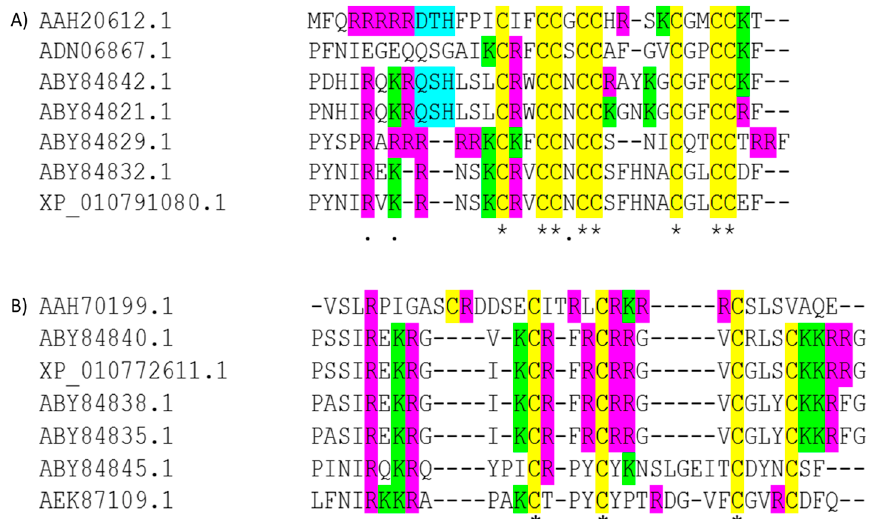
Figure 1. Multiple sequence alignment of Liver-Expressed Antimicrobial Peptides (LEAPs) from human (AAH20612.1, AAH70199.1); Dissostichus mawsoni (ABY84829.1, ABY84838.1); Lycodichthys dearborni (ABY84842.1, ABY84845.1); Notothenia angustata (ABY84832.1, ABY84835.1); Notothenia coriiceps (XP_010791080.1, XP_010772611.1); Pogonophryne scotti (ABY84821.1, ABY84840.1); and Epinephelus coioides (AEK87109.1, ADN06867.1). ( A ) The multiple sequence alignment of LEAP-1 shows highly conserved cysteine region and presence of basic amino acids arginine and lysine residues. The nLEAP-1 (Antarctic notothenioid liver-expressed antimicrobial peptide-1) and eLEAP-1 (Antarctic eelpout liver-expressed antimicrobial peptide-1) contain highly conserved arginine and lysine residues. eLEAP-1 contain ATCUN motif (Amino terminal Cu(II)- and Ni(II)-binding motif) which is also present in human LEAP-1 (Human liver-expressed antimicrobial peptide-1). ( B ) nLEAP-2 (Antarctic notothenioid liver-expressed antimicrobial peptide-2) shows highly conserved cysteine residues with conserved arginine and lysine amino acids and eLEAP-2 (Antarctic eelpout liver-expressed antimicrobial peptide-2) also shows conserved cysteine residues but contain low arginine and lysine amino acids as compared to other peptides. (Cysteine residues (C): highlighted with yellow colour; Arginine residues (R): highlighted with pink colour and lysine residues (K): highlighted with green colour).